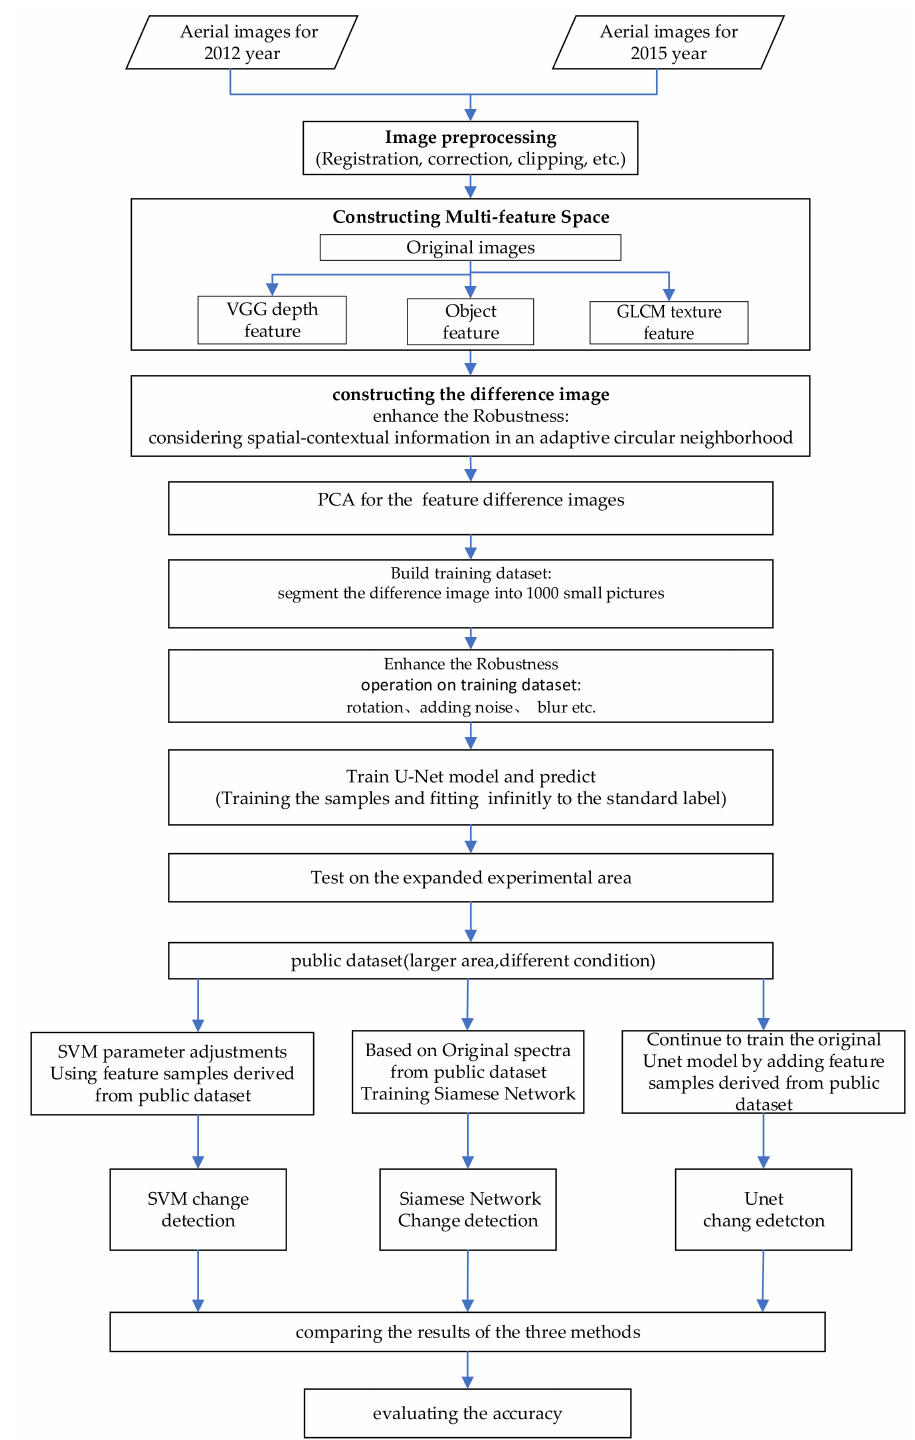
Figure 1. Flowchart of the proposed change detection